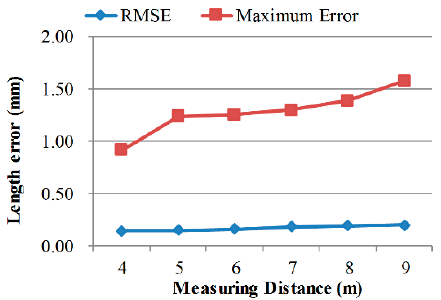
Figure 7. Calibration performances at different measuring distances.